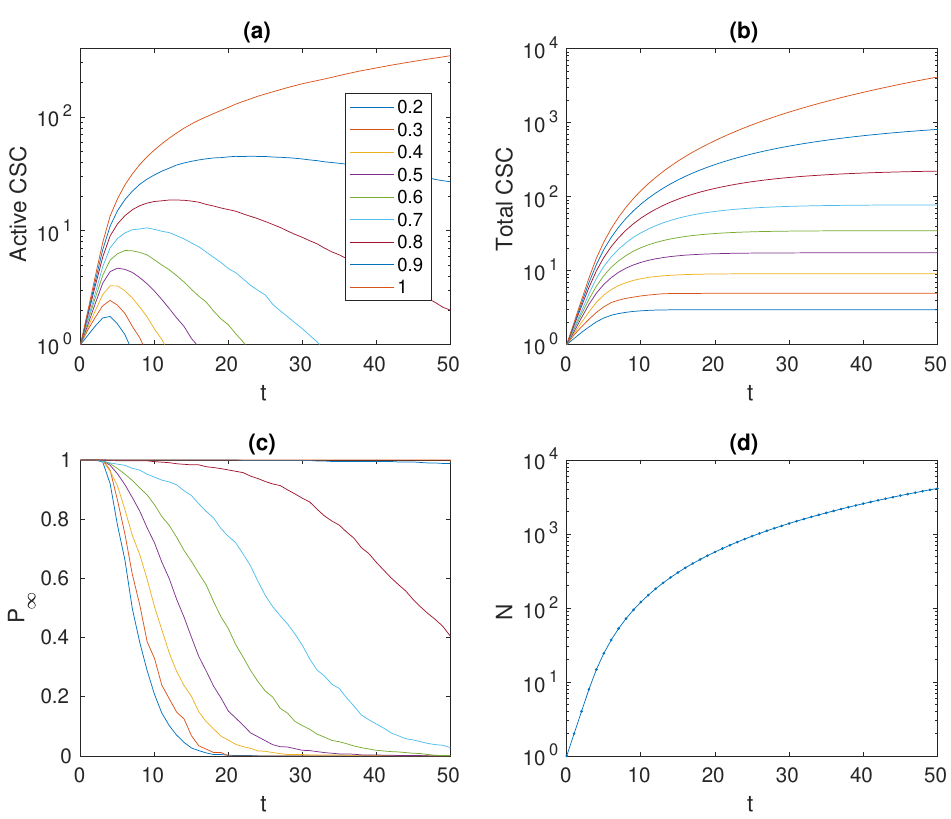
Figure 3: Time evolutions of quantities averaged over a thousand realizations for values of p s ∈ [0 . 2 .. 1 . 0]. (a) Number of CSCs at the border. (b) The total number of CSCs reaches a constant value that defines the